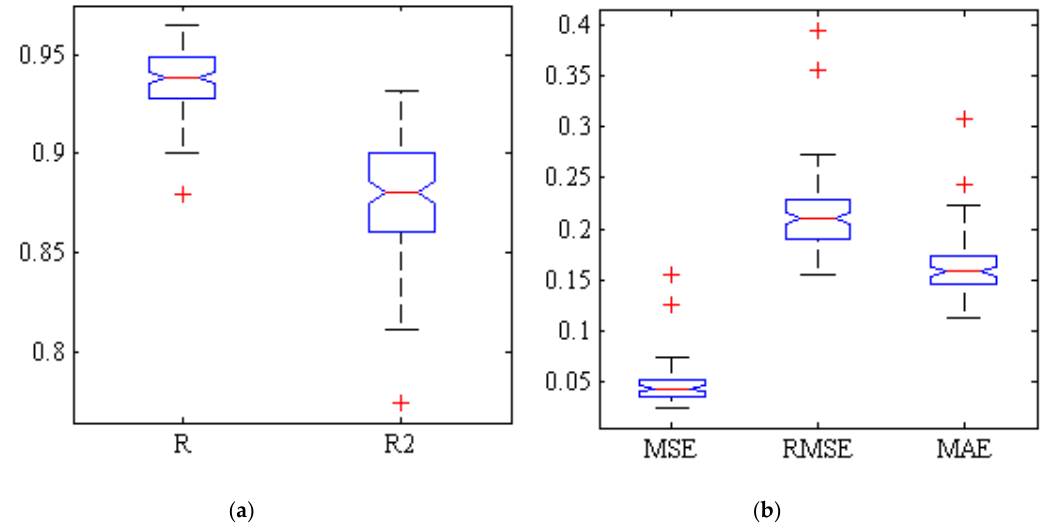
Figure 8. Box diagram of five criteria for evaluation of ANN-BBO performance in estimating starch content of Fuji apple on spectral data of the most effective wavelength, ( a ) coefficients of regression and determination, ( b ) error criteria.